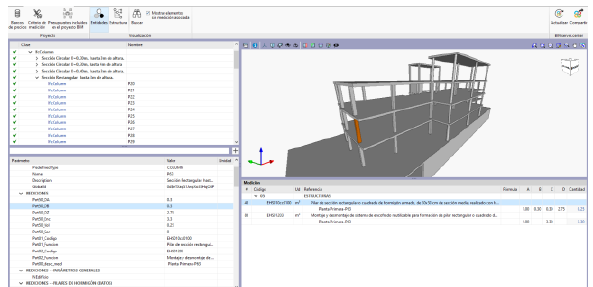
Figure 9 . The quantities of the Pilar entity (IFC file) are automatically associated with the work items in Quantities Cype.